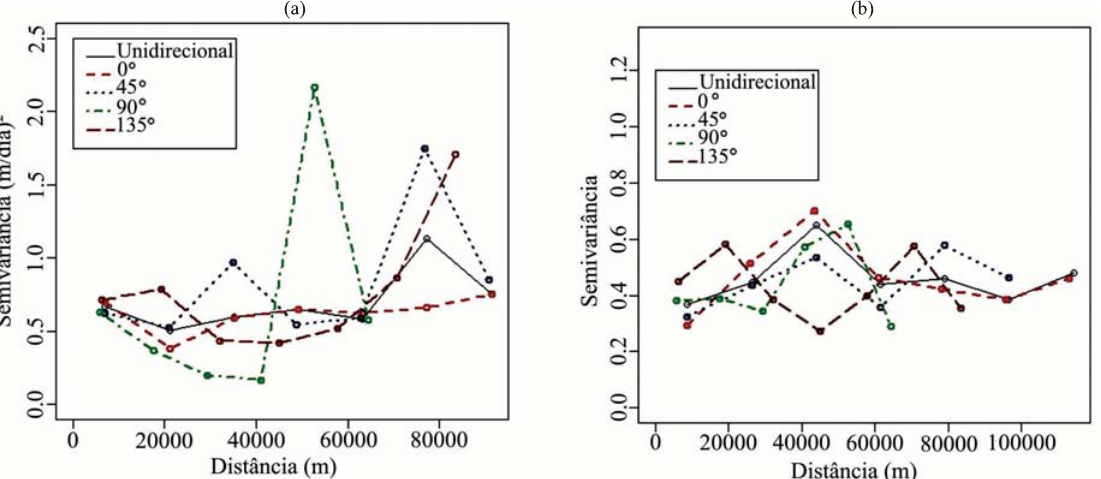
Figura 7. Estrutura de dependência espacial das quatro direções com os dados sem (a) e com transformação logarítmica (b).